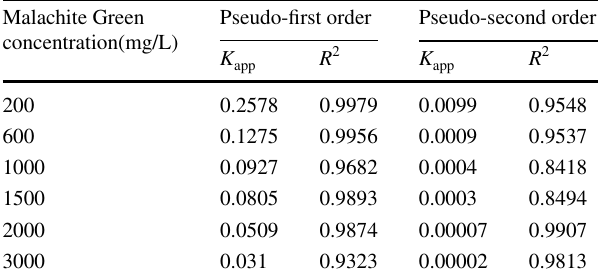
Fig. 8 The plots of pseudo-first- order reaction models fitted in EFP and ECP (C MG = 1000 mg L −1 , C D = 10 mA/cm 2 , pH = 3, C H2O2 = 50 mg L −1